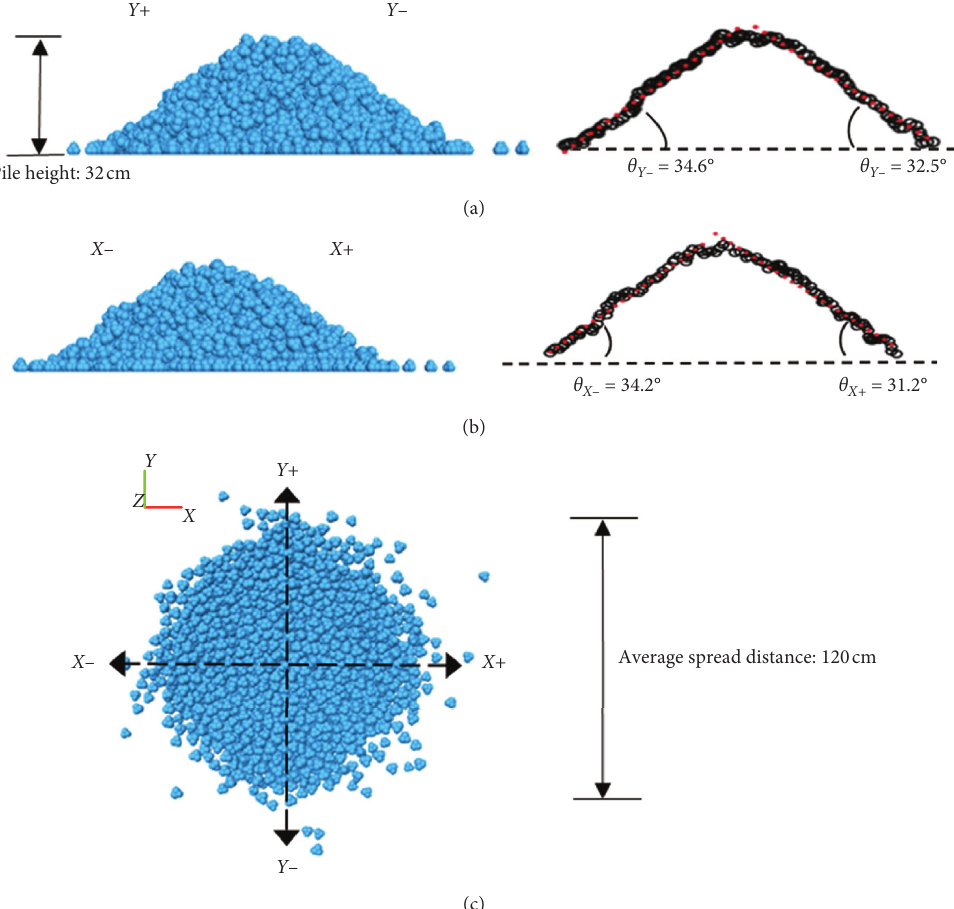
Figure 11: Ballast heap using four-ball tetrahedron clumps. (a) Side view. (b) Front view. (c) Plan view.